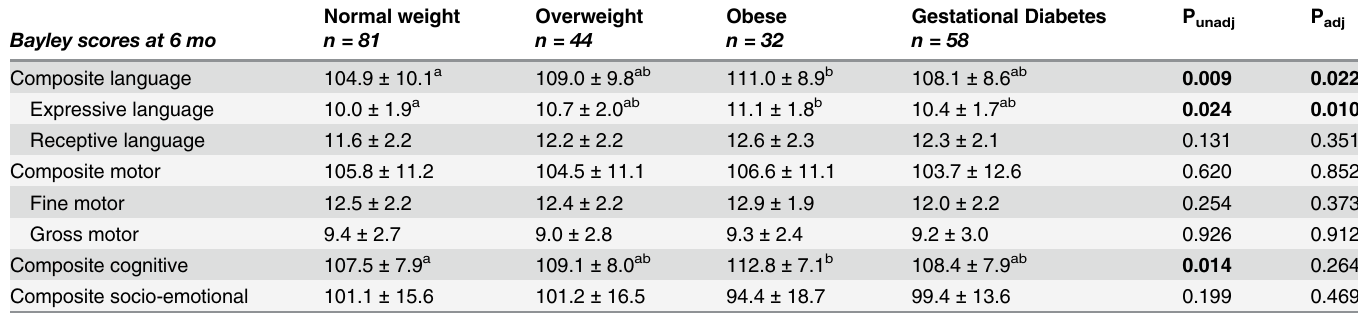
Table 2. Effects of maternal pre-pregnancy overweight, obesity or gestational diabetes on infant ’ s Bayley scores 1 at 6 months of age compared to those born to healthy normoweight pregnant women (controls). Normal weight